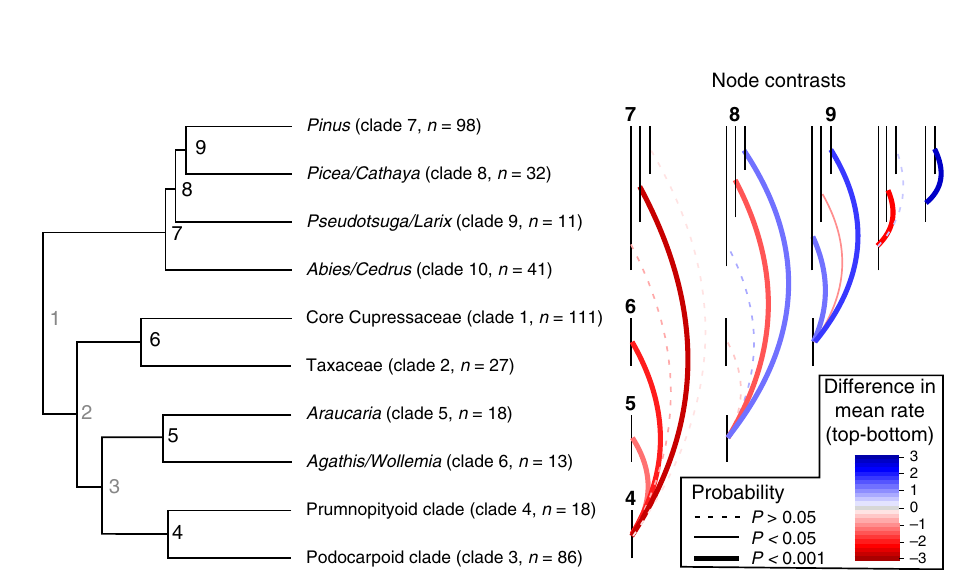
Fig. 5 Phylogenetic independent contrasts of niche evolution rate. Left: clade-level conifer phylogeny showing terminal nodes (4 – 9) in bold black, internal nodes (1 – 3) in grey (not consider in the contrasts). Taxonomic information about the groups, as well as their clade number and species richness (Clade #, n = species richness) are given at the tips. Right: Contrasts between the terminal nodes. The vertical bars correspond to the terminal nodes (labelled once in bold to match those on the tree), and the coloured arcs show the difference in mean niche evolution rate between the nodes (calculated by subtracting the mean of the top node from the mean of the bottom node). For example the red line joining nodes 5 and 4 indicates that the niche evolution rate at node 5 is 1.3 lower than node 4. Signi fi cance is indicated by line thickness and type. The pattern that emerges is that the nodes which give rise to clades with high species richness (e.g., nodes 4 and 9) have signi fi cantly higher niche evolution rates than nodes giving rise to clades with low species richness (with the exception of node 6, see Results and Discussion). For further details on the contrasts see Supplementary Table